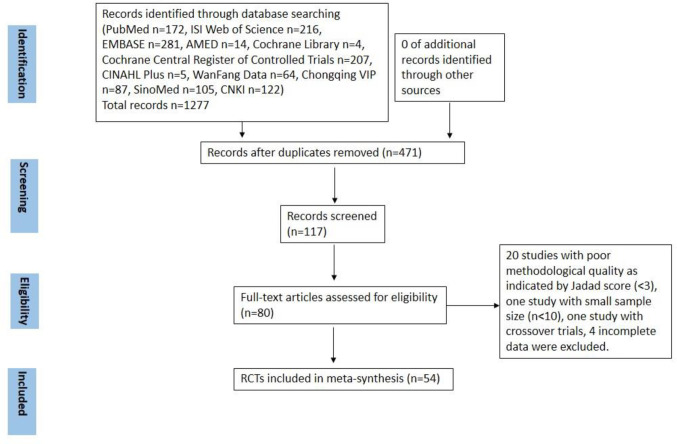
Study flow diagram.